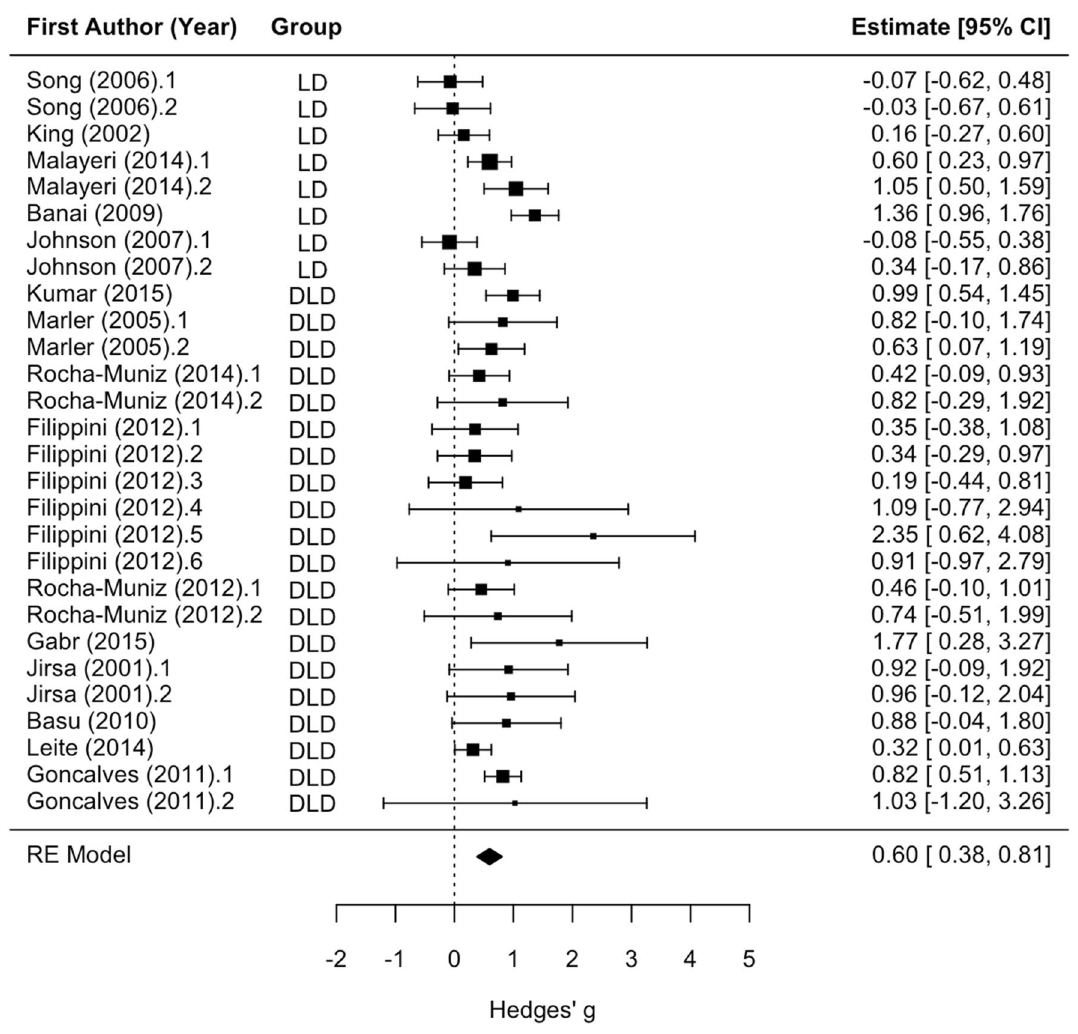
Figure 6. Wave V Overall latency effect forest plot. Positive values of Hedges’ g indicate longer latency for the disorder group relative to controls. Rows with decimal points after the article year indicate multiple analyses from the same paper, and correspond to the row order of the analysis in the systematic review table in Supplement